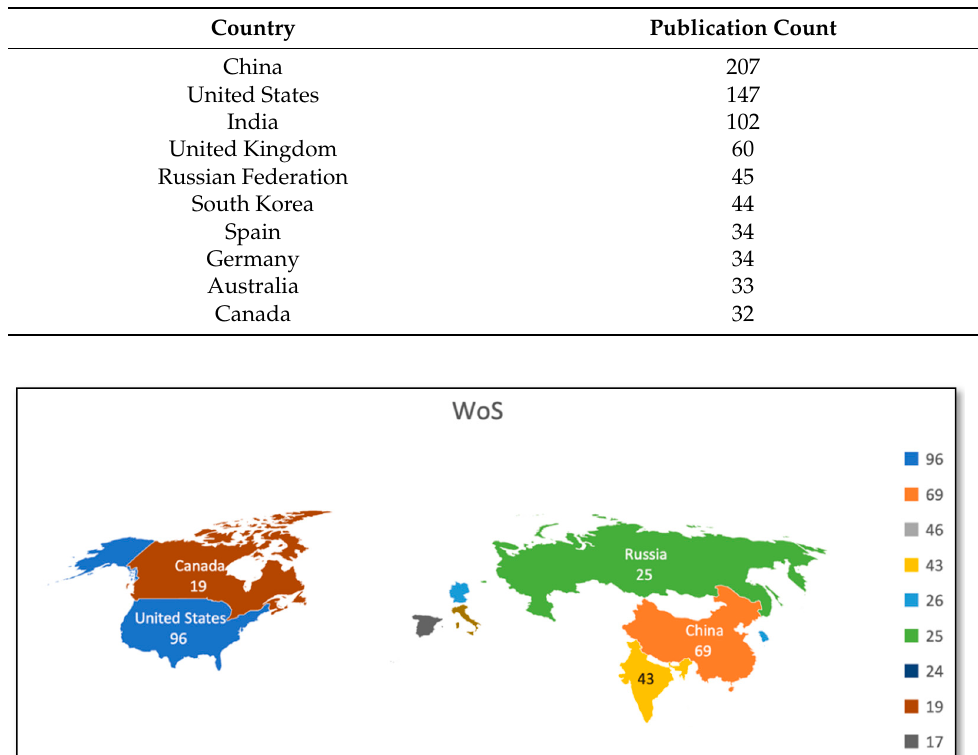
Figure 9. Publications by geographical area (Scopus). Table 7. Publication count by geographical area (Scopus Database).